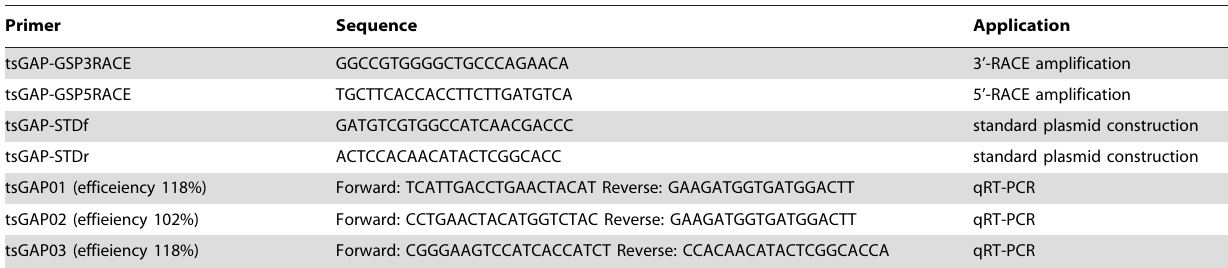
Table 2. Primers used in this study.